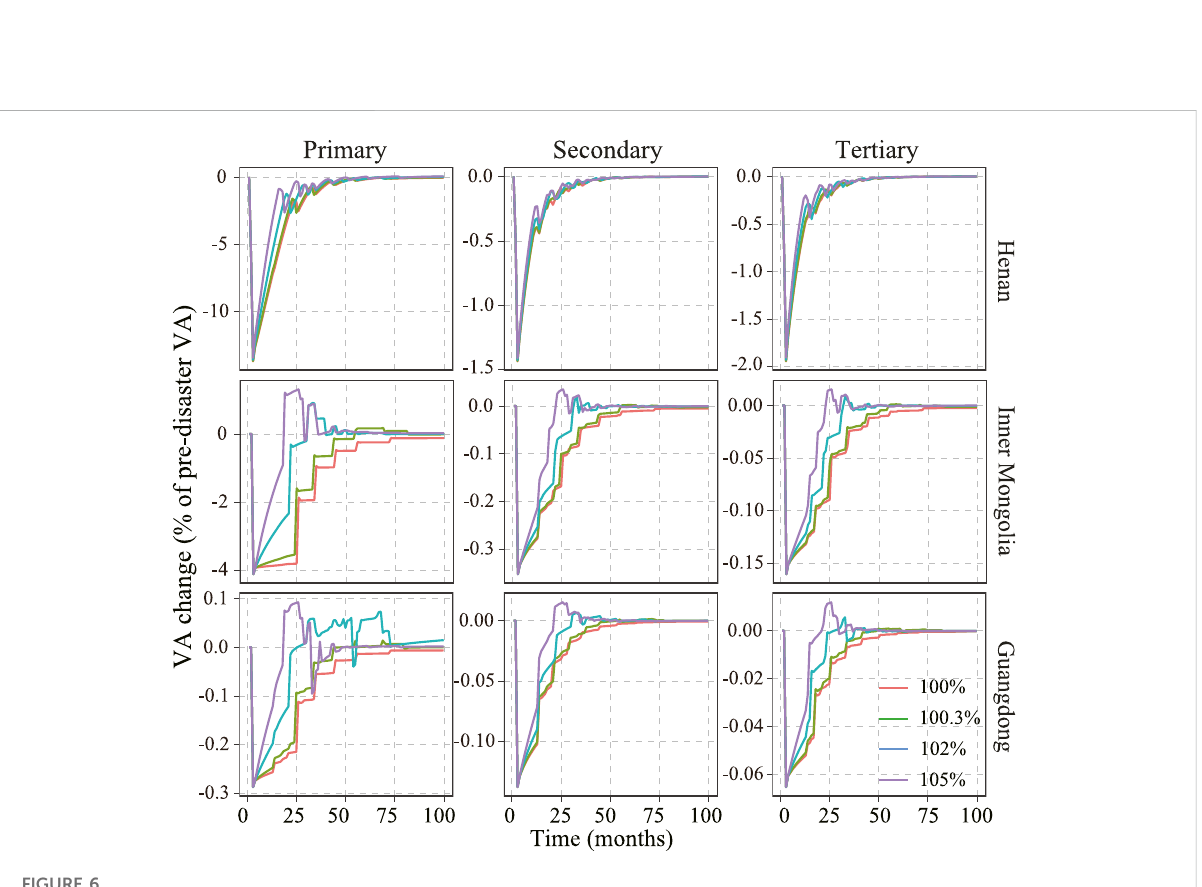
Variations inVAinthethreemajor industries(%ofthepre-disasterlevel) inHenan,Guangdong,andInnerMongoliaunderdifferentscenariosof overproduction